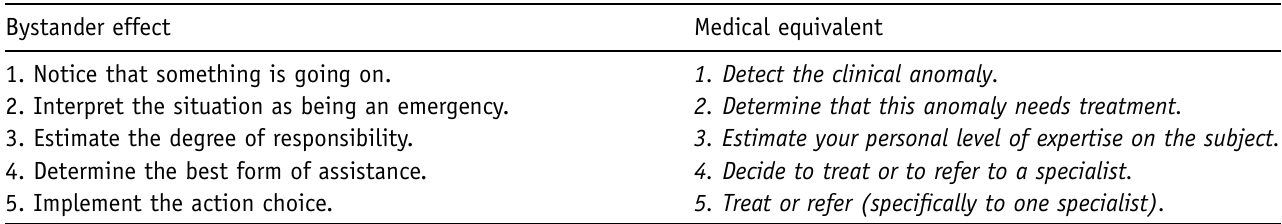
Table I. Adaptation of the bystander effect cognitive model [10] to the medical diagnostic process. Bystander effect Medical